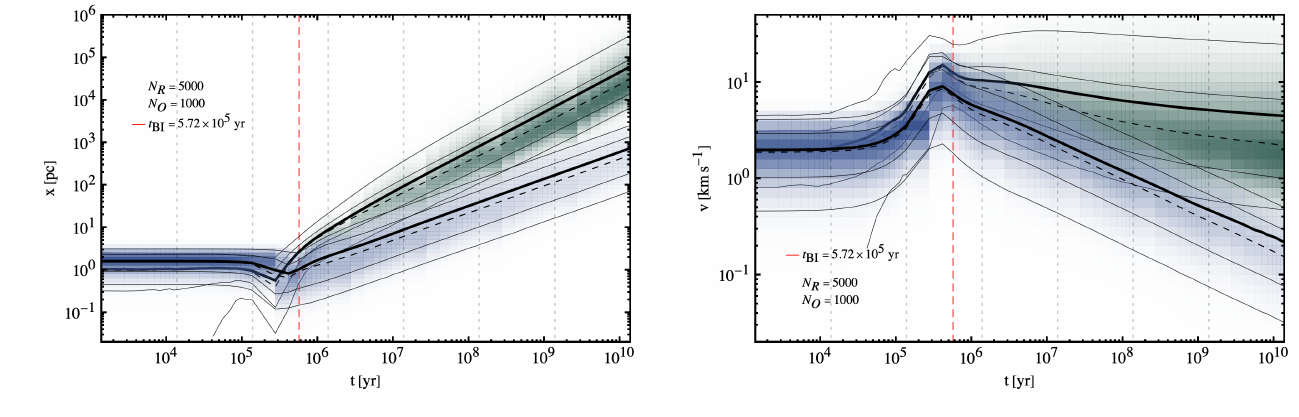
Figure 7. Positions and velocities time evolution of a subset 10% of objects in one particular realisation. In blue and teal are the position and velocity curves for cluster and ejecta objects, respectively. For both positions and velocities, the thick black line mark the mean of the discrete distribution of evolution trajectories per snapshot, while the thin black line in the same panel represents the median, and the thin black lines mark the 68% and 95% confidence regions. The mean fits obtained for the position and velocity profiles at each time slice are shown